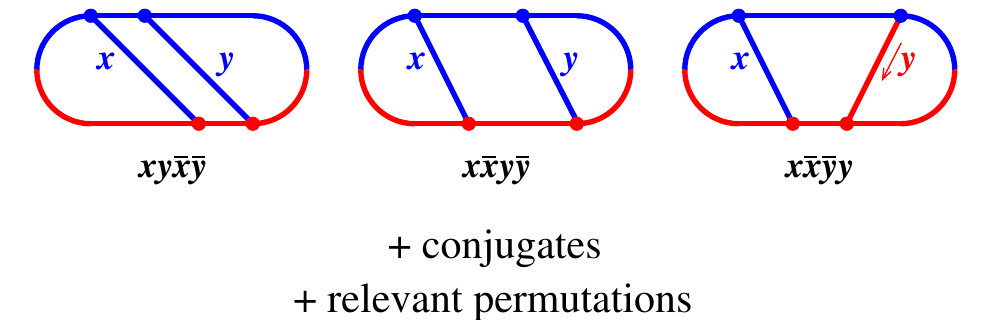
Figure 7 . The above diagrams contributing to double splitting g → ggg are called the “sequential diagrams” in ref. [18]. As in refs. [16, 18], the diagrams are individually named ( xy ¯ x ¯ y , etc.) by the time order of the vertices. The relevant permutations referenced above are those permutations of the daughters x , y , and z ≡ 1 − x − y that create distinct